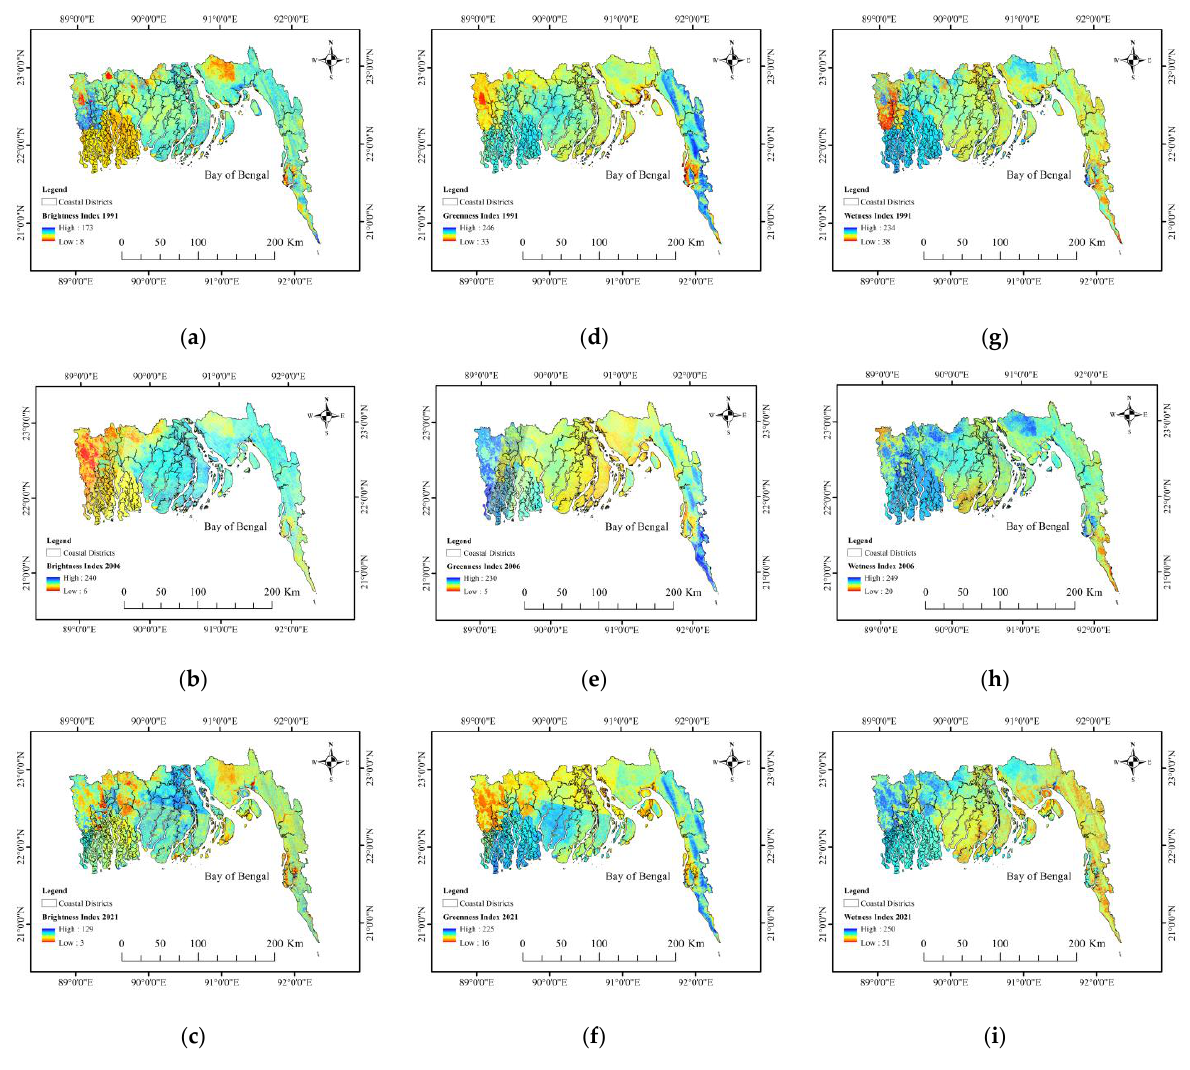
Figure 4. Brightness index: ( a ) 1991, ( b ) 2006, and ( c ) 2021; Greenness index: ( d ) 1991, ( e ) 2006, and ( f ) 2021; Wetness index: ( g ) 1991, ( h ) 2006, and ( i ) 2021 of coastal districts, Bangladesh delta.